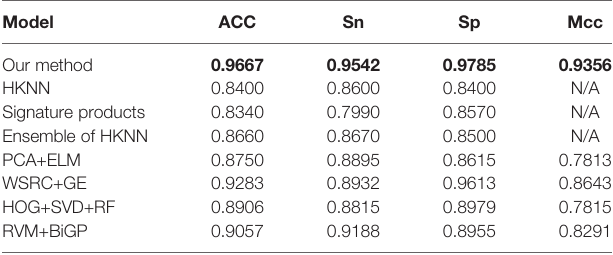
TABLE 6 | Comparing the prediction performance by the proposed method (FCTP-WSRC) and some state-of-art works on the Yeast